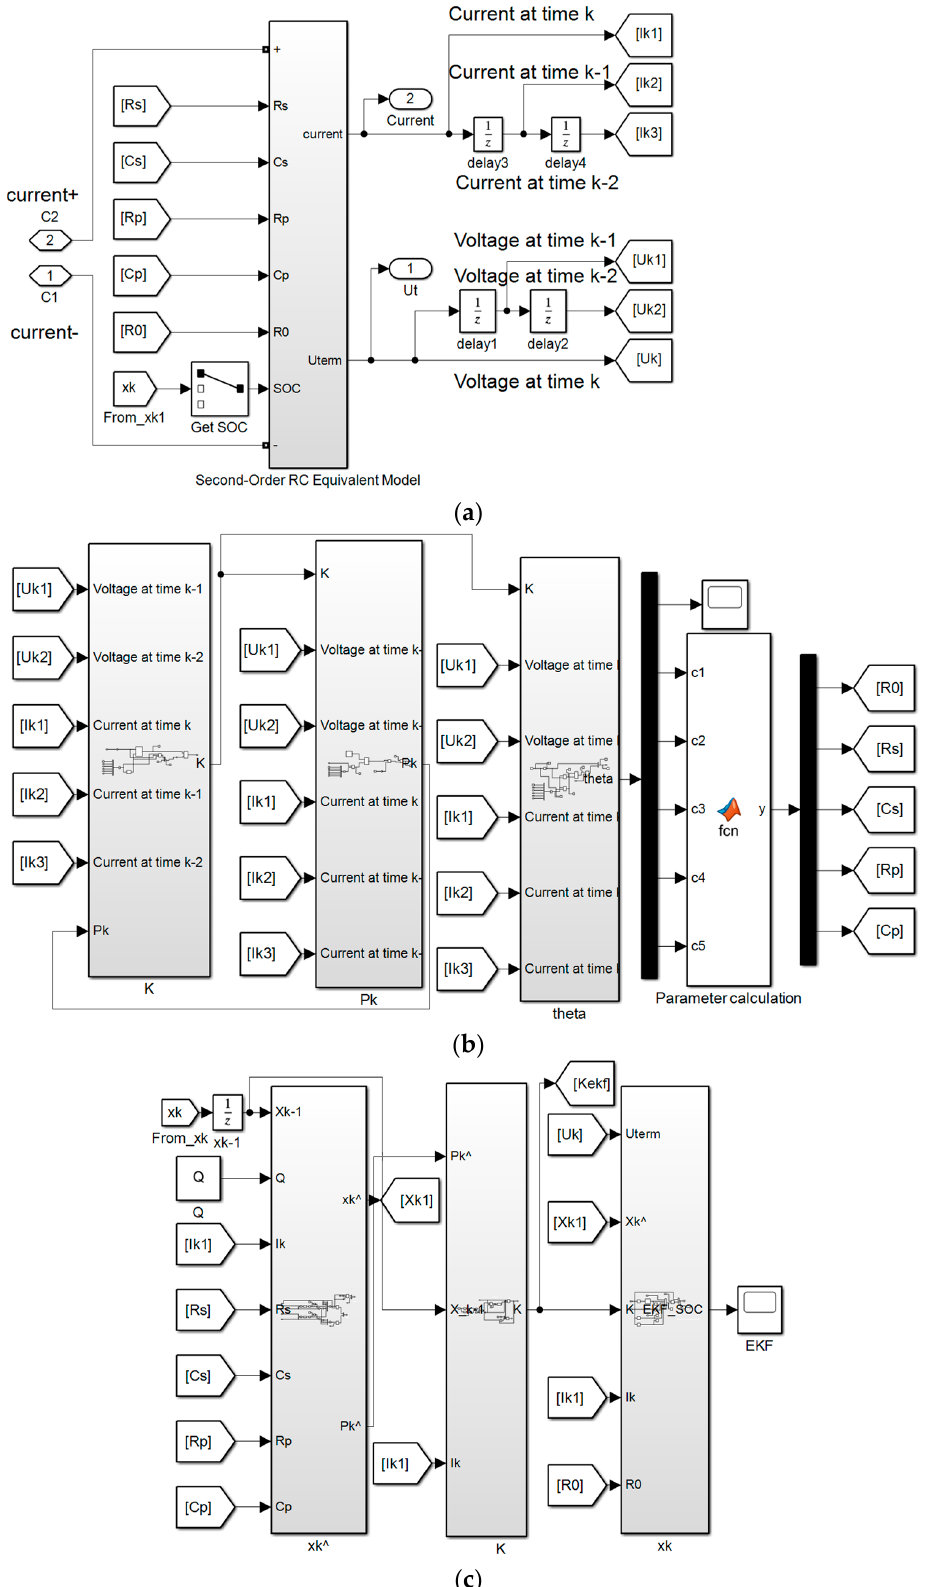
Figure 13. Battery SOC estimation module. ( a ) Equivalent circuit model section. ( b ) The online parameter identification part of the FFRLS method. ( c ) EKF estimated SOC section. The battery parameters are set according to the data in Table 2. Table 2. Battery parameters.